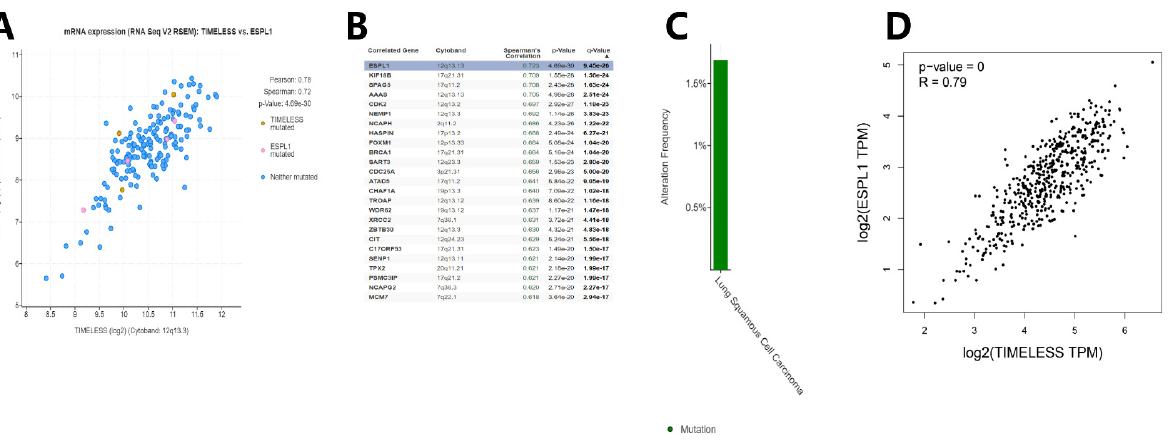
Figure 6. Genetic mutational and correlational analysis of Timeless gene in the patients with lung adenocarcinoma. ( A , B ) Correlation analysis between the Timeless gene and its co-expressed genes using the cBioPortal tool. ( C ) Genetic mutational analysis of the Timeless gene in lung adenocarcinoma. ( D ) Pearson correlation analysis between Timeless and ESPL1 genes using the GEPIA database. ESPL1, extra spindle pole bodies like 1.